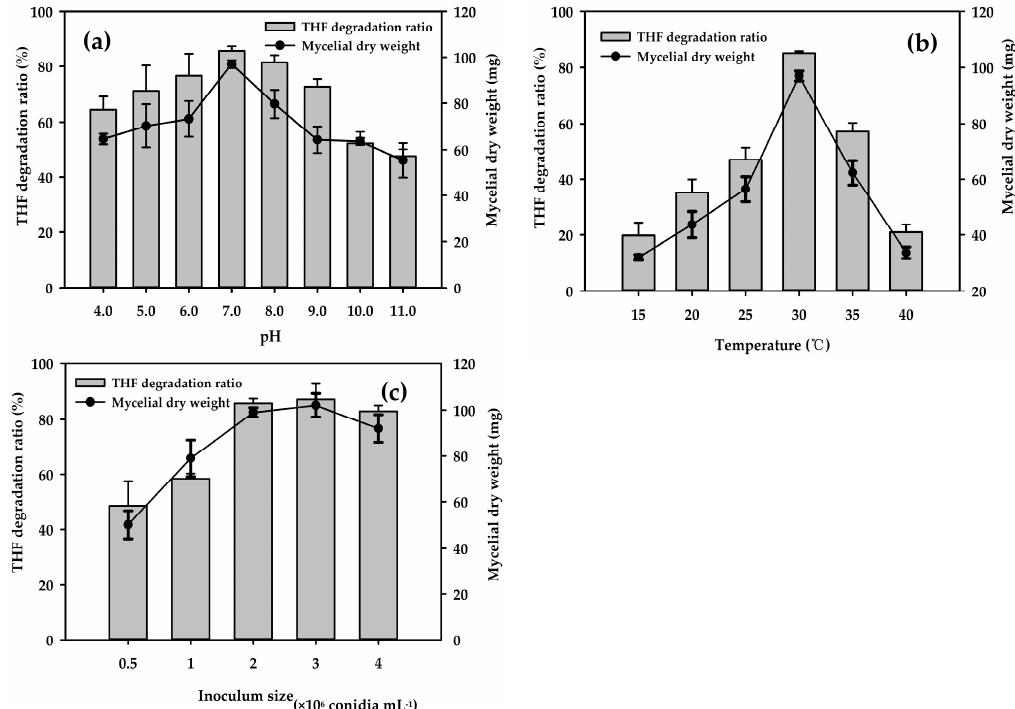
Figure 3. Effect of different initial pH values, incubation temperatures, and inoculum sizes on the biodegradation of THF by strain ZM01: The THF degradation ratio was detected after cultivation for 8 d at 50 mM THF. ( a ) pH; ( b ) temperature; and ( c ) inoculum size.